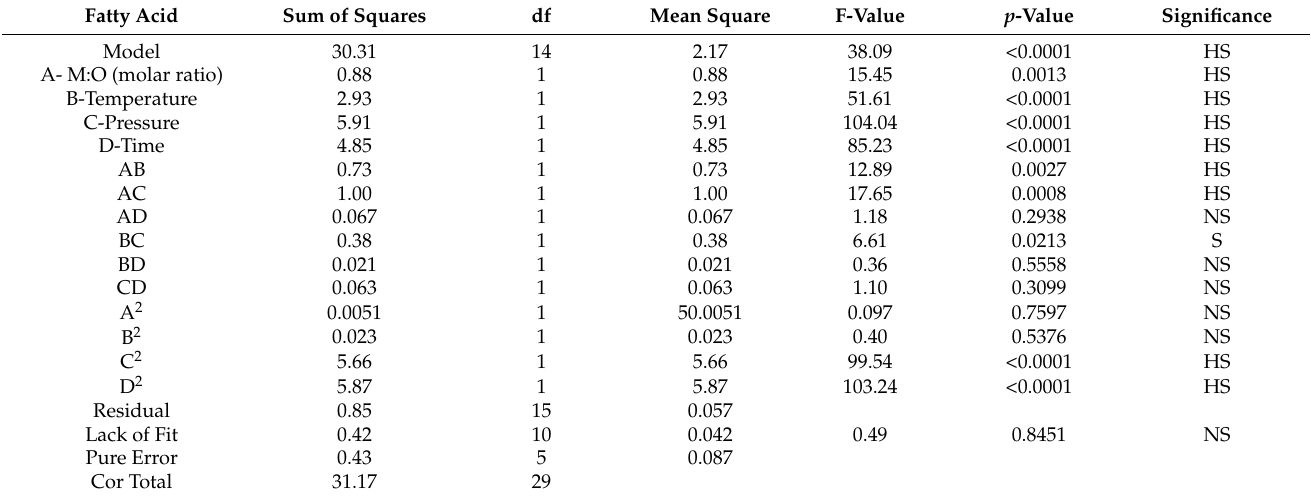
Table A3. Analysis of variance for FAME yield of methyl-linoleate model.